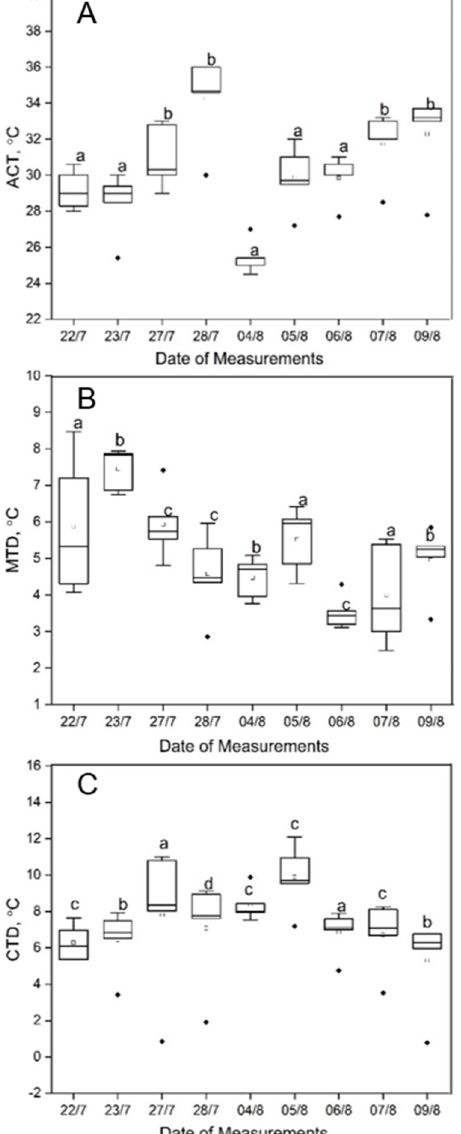
Figure 7. Crop parameters during the experiment ( A ) average canopy temperature (ACT), ( B ) maximum temperature difference (MTD), ( C ) canopy temperature difference (CTD). Same letters i.e., a, b,c are not significantly different (P < 0.001).